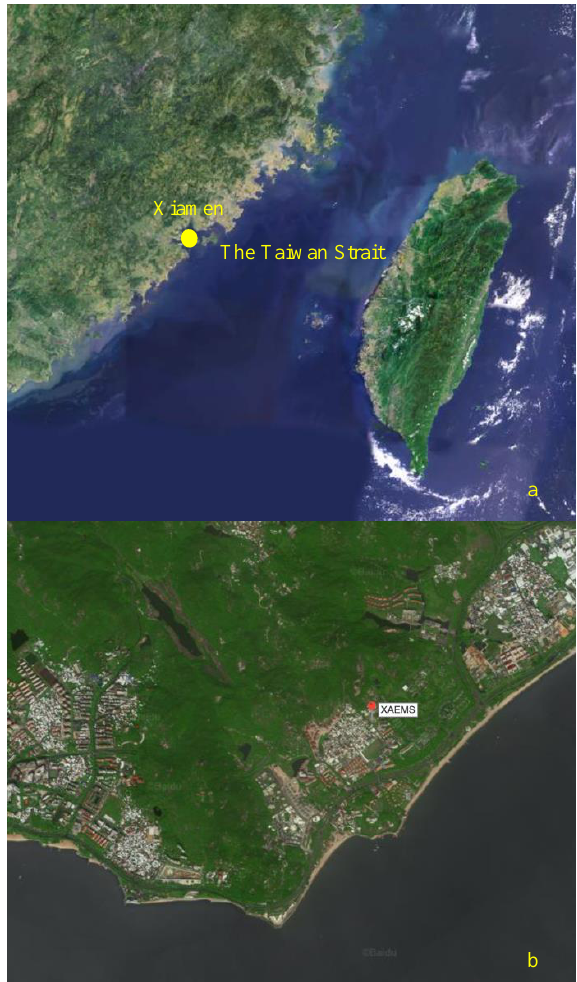
Figure 1. Geographical location map of Xiamen city (a) and XAEMS (b) Figure 2. Monthly concentration of PM 2.5 (The upper dash indicate the maximum, the lower dash indicate the minimum, the upper “X” indicate the 99% value, the lower “X” indicate the 1% value, the small square indicate the mean value, the upper edge of the box indicate the 75% value, the lower edge of the box indicate the 25% value, the horizontal line in the box indicate the median) To illustrate the status of PM 2.5 pollution in Xiamen, concentration of PM 2.5 were compared with other cities over China and foreign countries (Table 1). Compared with other cities in China, PM 2.5 concentration in Xiamen was lower than those values observed in inland cities and many coastal cities in China, such as Beijing (51 μg/m 3 ), Xi’an (63 μg/m 3 ), Chengdu (51 μg/m 3 ), Wuhan (49 μg/m 3 ), Dalian (30 μg/m 3 ), Qingdao (34 μg/m 3 ), Shanghai (36 μg/m 3 ), Ningbo (33 μg/m 3 ), Guangzhou (35 μg/m 3 ), but much higher than Haikou (18 μg/m 3 ). Due to